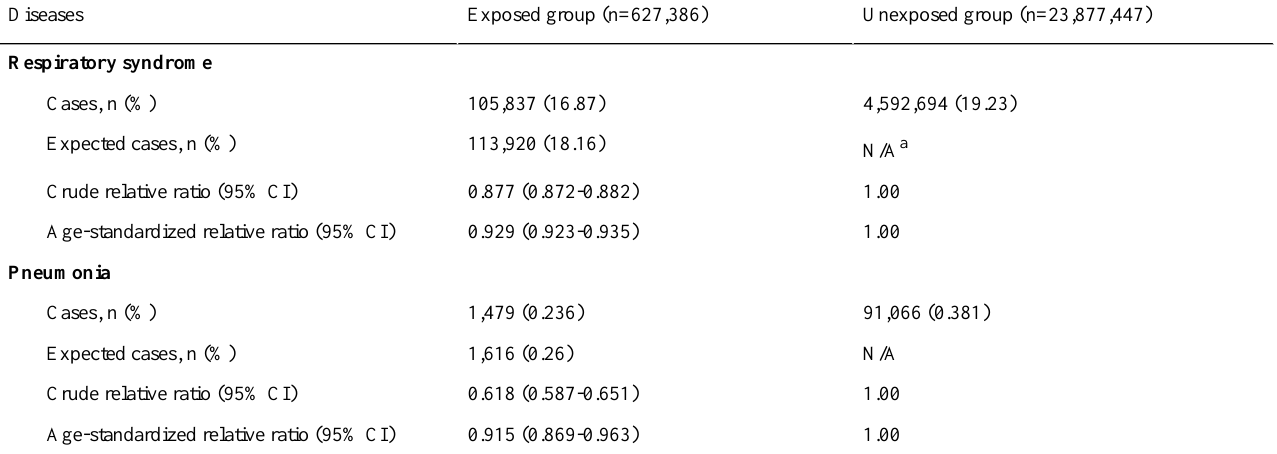
Table 2. Respiratory syndrome/pneumonia cases, rates, and relative ratios in the exposed group and unexposed